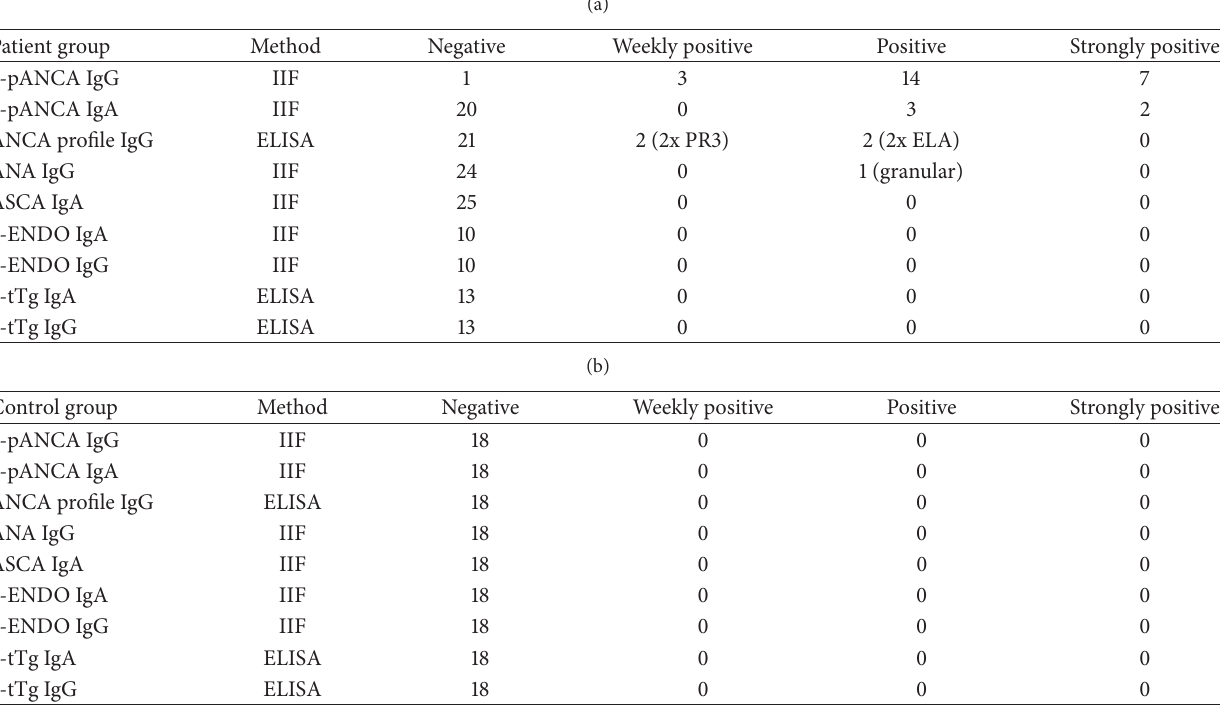
Table 3: Other antibodies (patient group and control group).